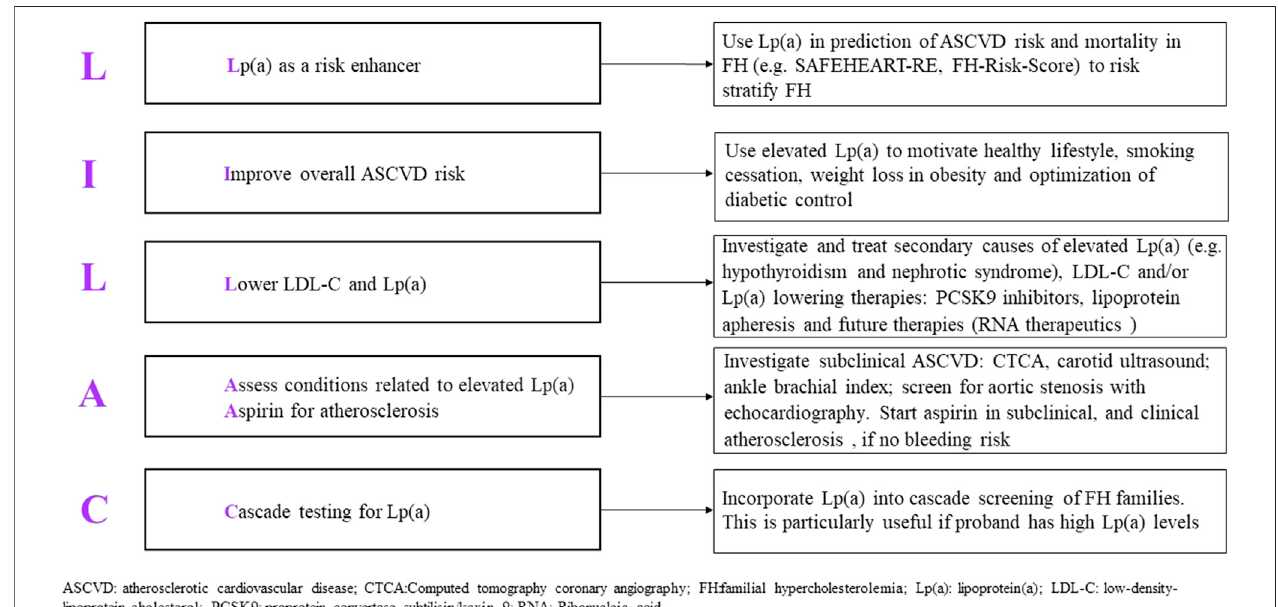
FIGURE 6 | Proposed mnemonic (LILAC) for the management of elevated lipoprotein (a) in familial hypercholesterolemia.